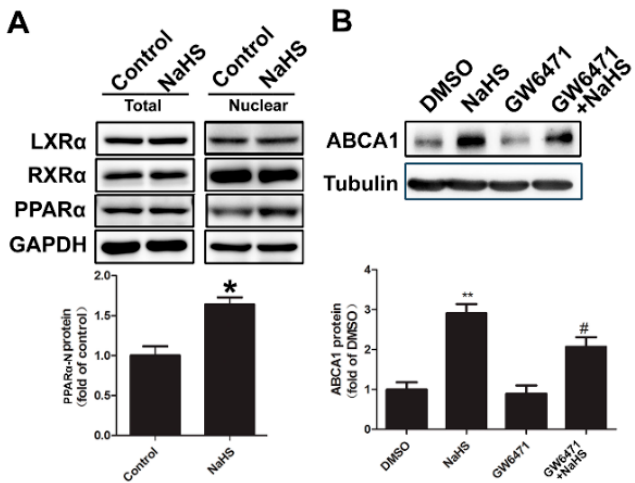
Figure 4. The increase of ABCA1 expression induced by NaHS is mediated by PPAR α . ( A ) Total proteins and nuclear proteins of HepG2 cells were prepared after NaHS treatment (100 μ M for 2 h). Samples of the proteins were subjected to Western blot with antibodies against LXR α , RXR α , and PPAR α . GAPDH were used as the loading controls. The blots of nuclear PPAR α were then quantified by ImageJ software ( n = 3, * p < 0.05 vs. control); ( B ) HepG2 cells were pretreated with PPAR α antagonists GW6471 (25 μ M) for 14 h, followed by additional NaHS (100 μ M) treatment for 8 h. Cell lysates were collected and probed with anti-ABCA1 and tubulin antibodies ( n = 3, ** p < 0.01 vs. DMSO; # p < 0.05 vs. NaHS).